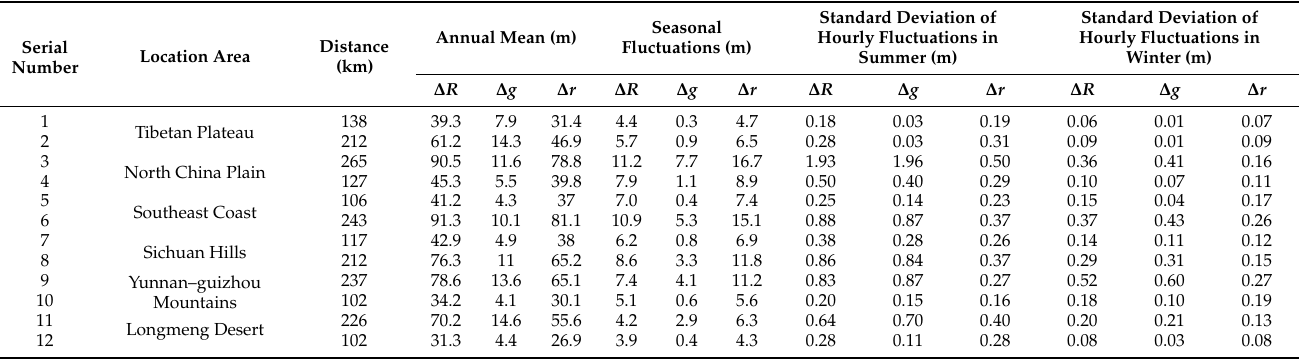
Table 2. Statistical results of 12 link delay